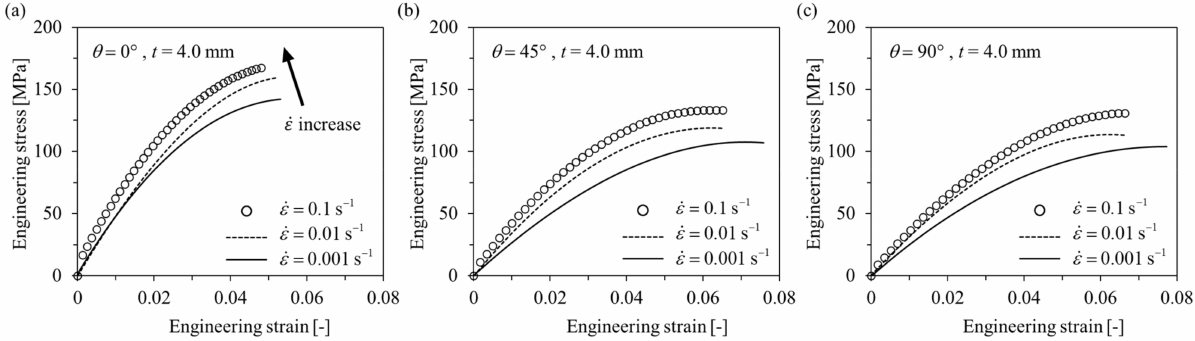
Figure 6. Tensile engineering stress–engineering strain curves of t = 4.0 mm specimens with different strain rates. ( a ) θ = 0 ◦ , ( b ) θ = 45 ◦ , ( c ) θ = 90 ◦